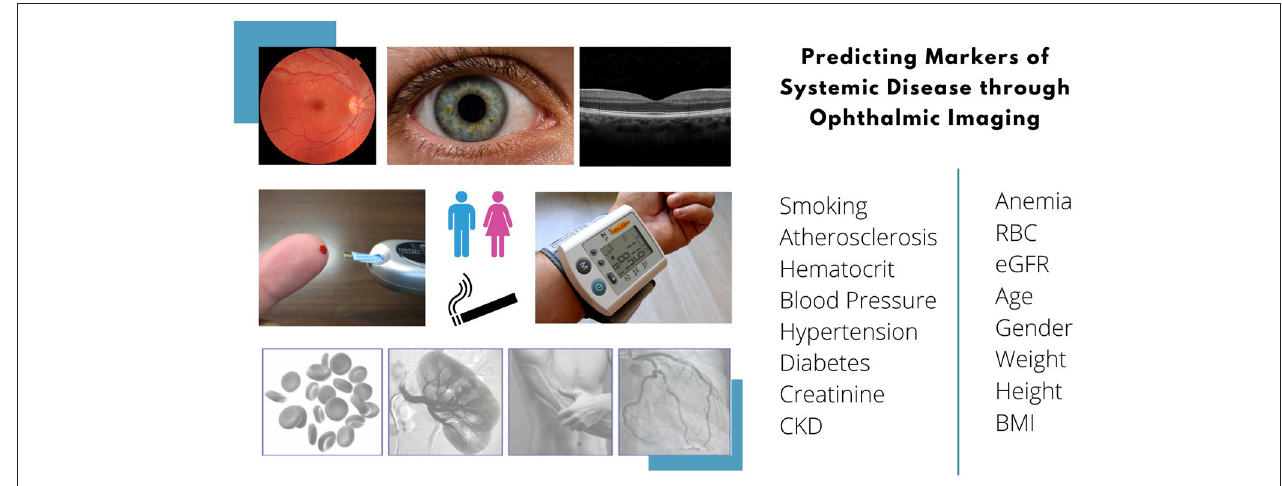
FIGURE 1 | Overview of predictable systemic biomarkers from ophthalmic imaging modalities.